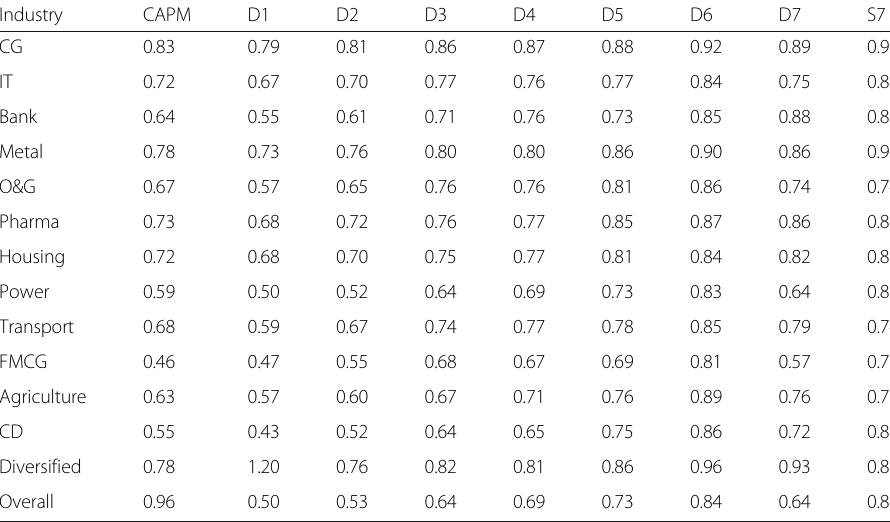
Table 6 Corresponding wavelet R-squares